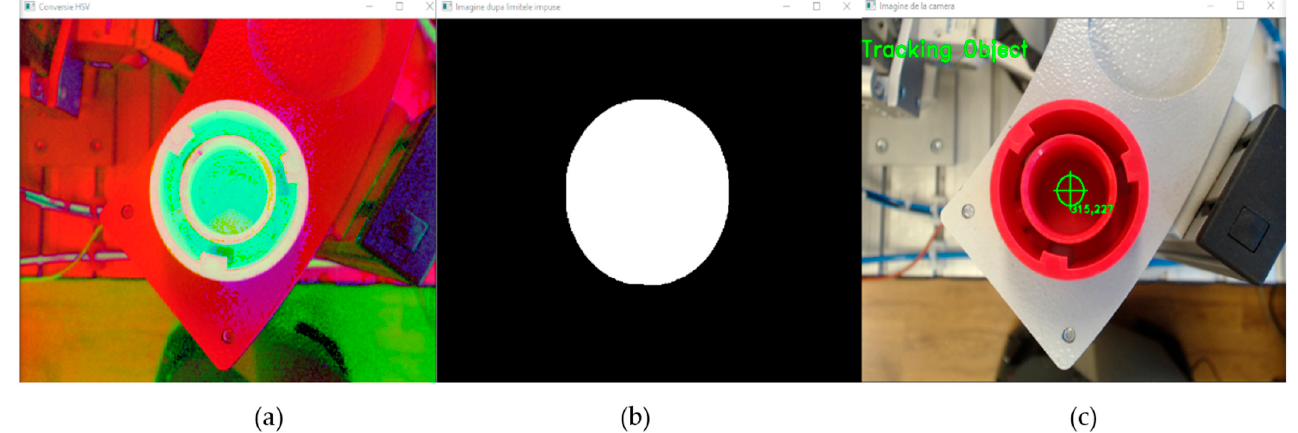
Figure 13. Object Detection of the workpiece with the following steps: ( a ) Conversion from RGB to HSV ( b ) image segmentation after the color has been found between the HSV limits and the shape corresponding to object has been found ( c ) object color and shape has been found and is being tracked.